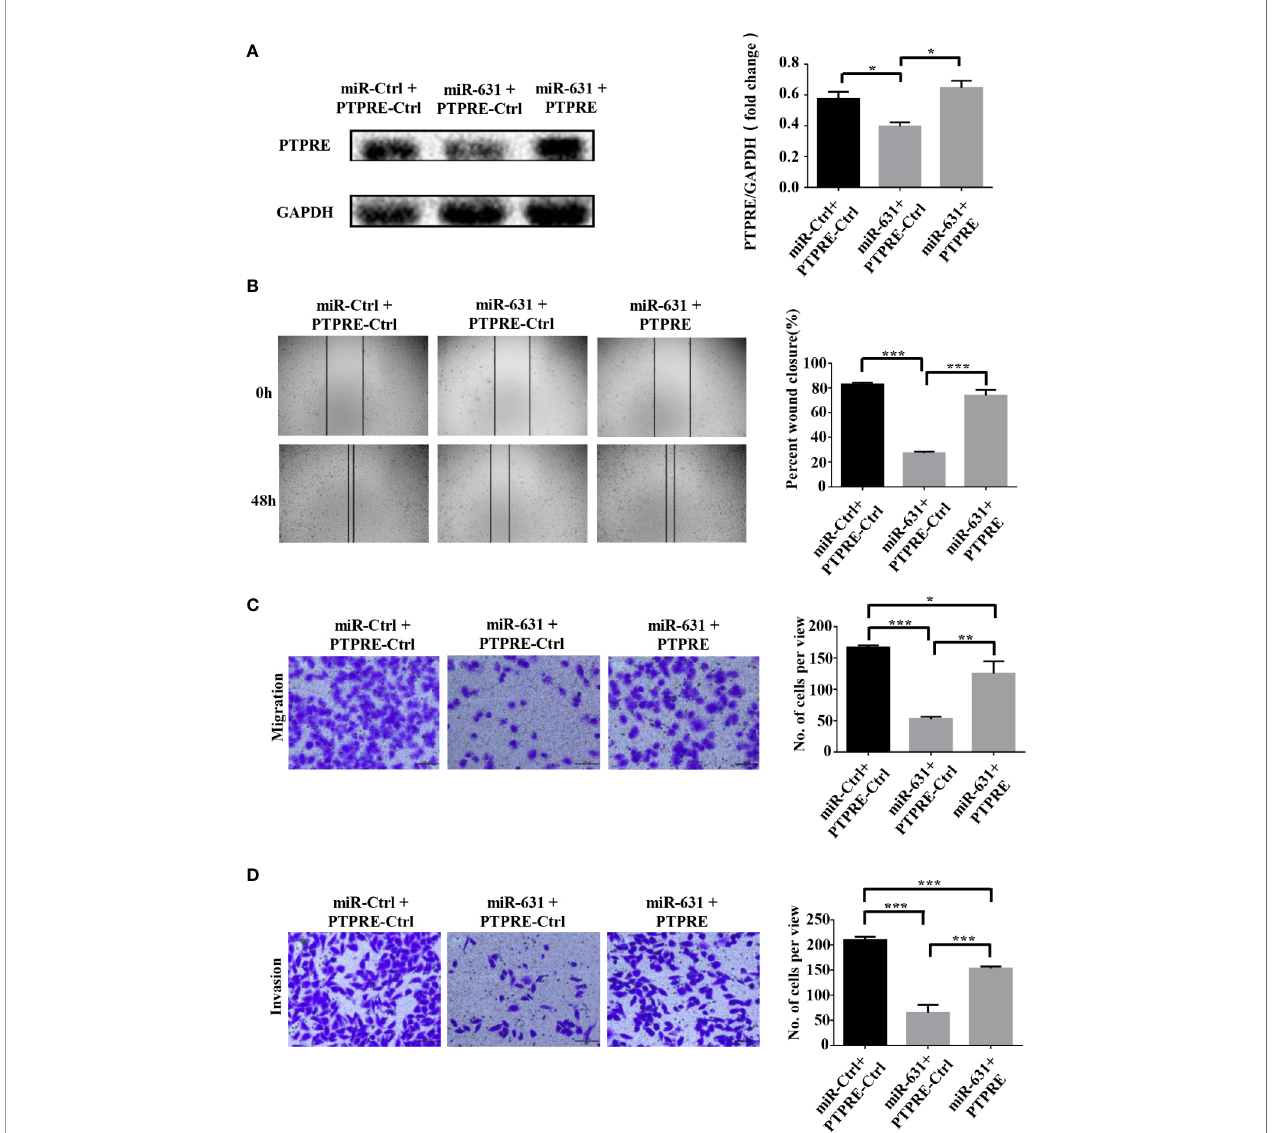
FIGURE 5 | miR-631 inhibits migration and invasion in HCC cells through PTPRE. (A) BEL-7402 cells were separated into three groups for carrying out a rescue experiment. (B) The representative images of wound healing assay were obtained and the percentages of wound closure were calculated. (C, D) Transwell migration and invasion assays of rescue experiment. *P < 0.05; **P < 0.01; ***P <